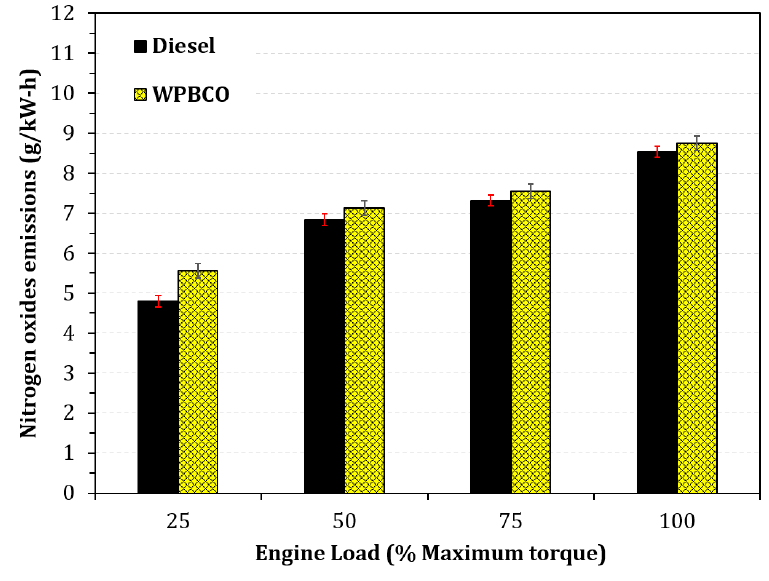
Figure 9. Variation in nitrogen oxide emissions with respect to the engine load.